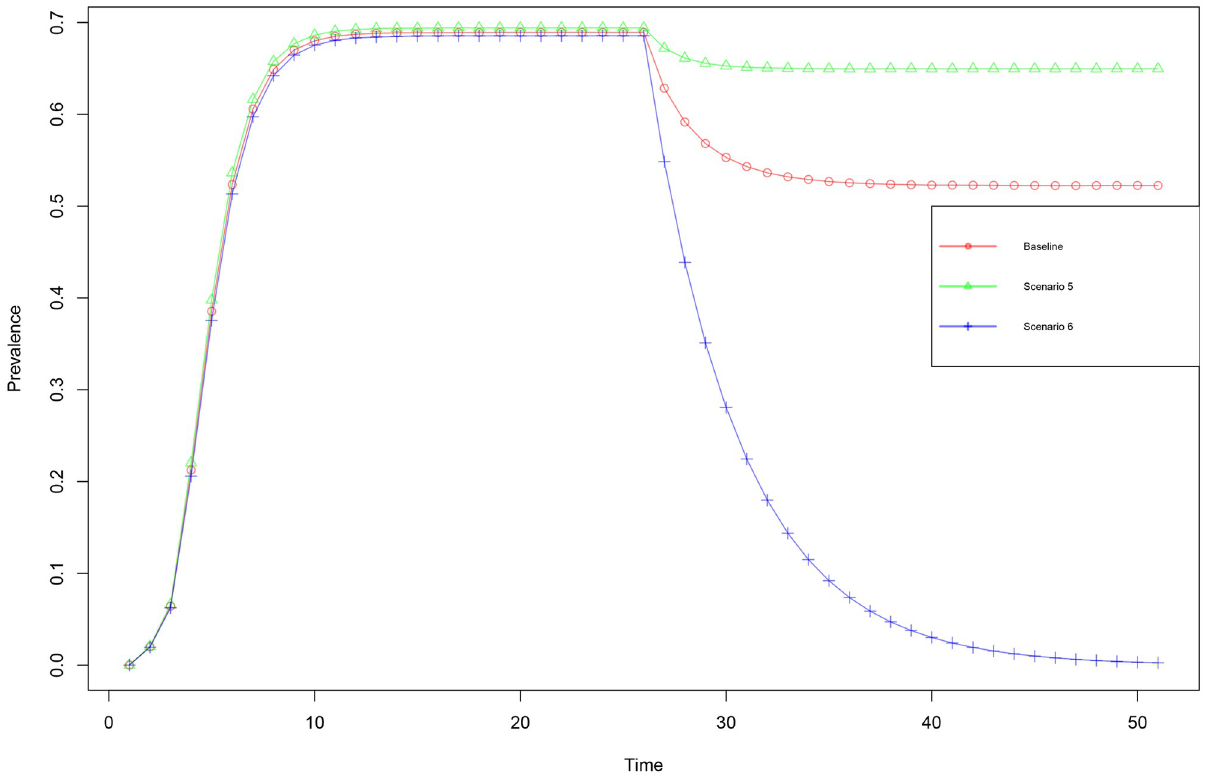
Fig 4. For network 1 with random seeding the mean prevalence over time is depicted under random seeding on network 1 for the 3 scenarios with the same overarching propagation likelihood ( λ = 0.192). The baseline scenario, the red open circles, a process with homogeneous sub-processes ( α = ϕ = η = 0.5769). Scenario 5, the green triangles, a process with α = 1.0, ϕ = 1.0 and η = 0.192. Scenario6, blue pluses, a process with α = 0.2, ϕ = 1.00 and η = 0.96. During the simulation at t = 25 an intervention (reduction of 0.2) in the radiation is applied.